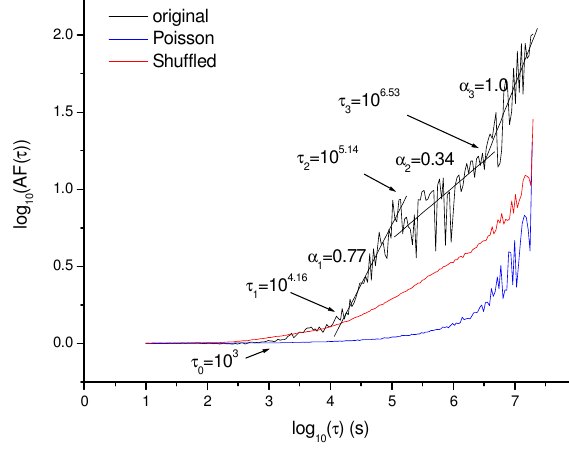
Fig. 2. AF of the seismic sequence recorded in the Aswan area plotted in Fig. 1 and for m ≥ 1 . 2 and depth h ≤ 15km. The blue curve is the Poissonian 95% confidence and the red curve is the random shuffling 95%